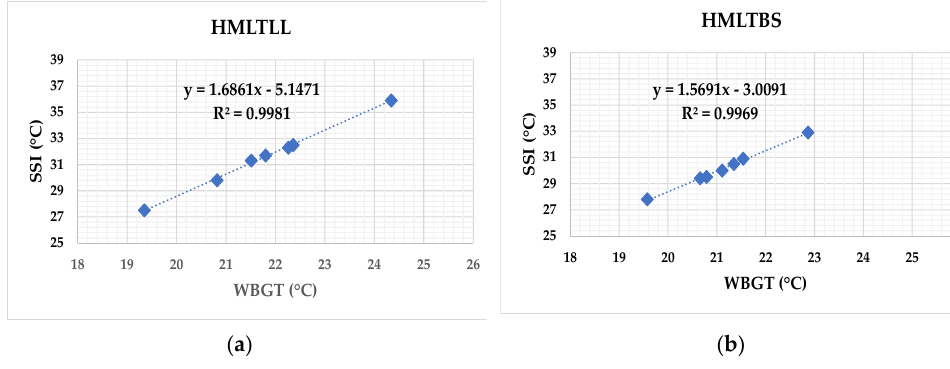
Figure 7. Associations between the WBGT and SSI values in ( a ) HMLTLL and ( b ) HMLTBS.